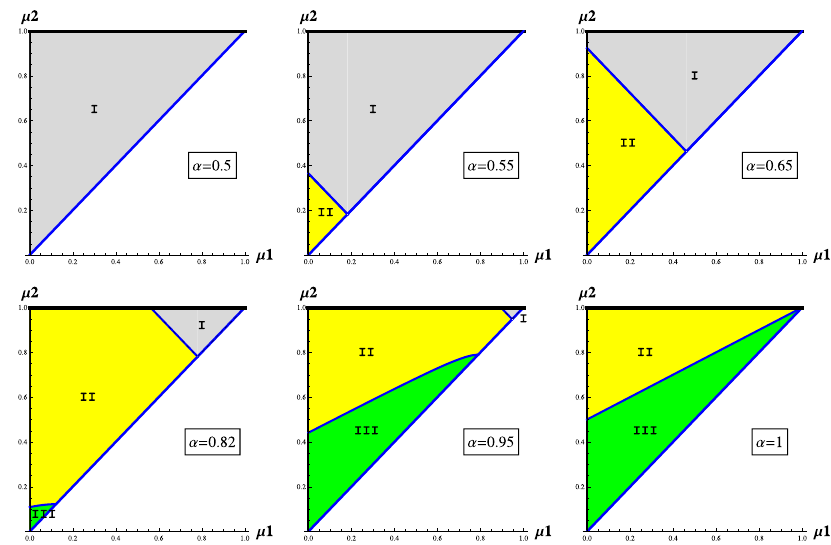
Fig. 4 We represent Regions I, II, and III in equilibrium as a function of the pairs (μ 1 ,μ 2 ) satisfying < μ μ 1 2 , for different values of parameter and F ∗ 1 , news = F ∗ 2 , news (color figure